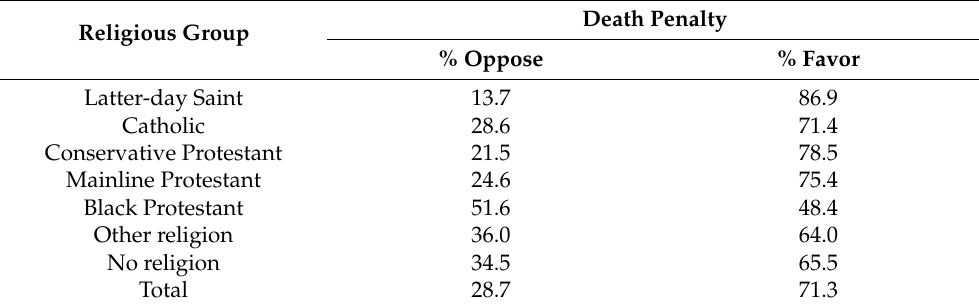
Table 2. Cross-Tabulation of Religious Group by Attitudes toward the Death Penalty.